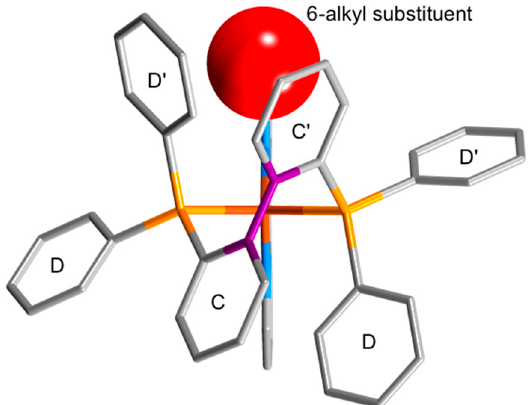
Figure 2. Modelled structure (not energy minimized) of [Cu(BIPHEP)(6-Rbpy)] + , in which the alkyl group R is represented by the red sphere and the trans-annular bond in the biphenyl unit is shown in purple. Partial rotation about the latter renders the two D' rings equivalent and the two D rings equivalent, but the pair C and C', and the pair D and D', remain non-equivalent.